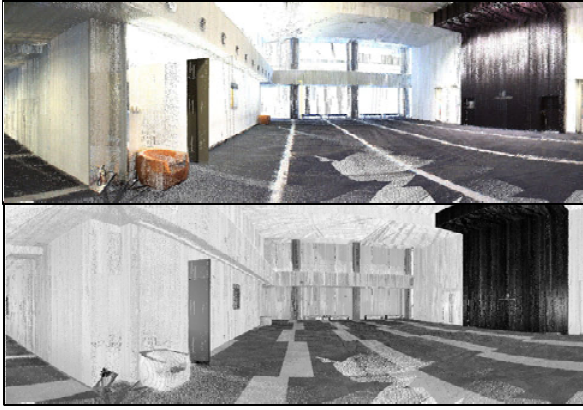
Figure 9. Rendered point cloud